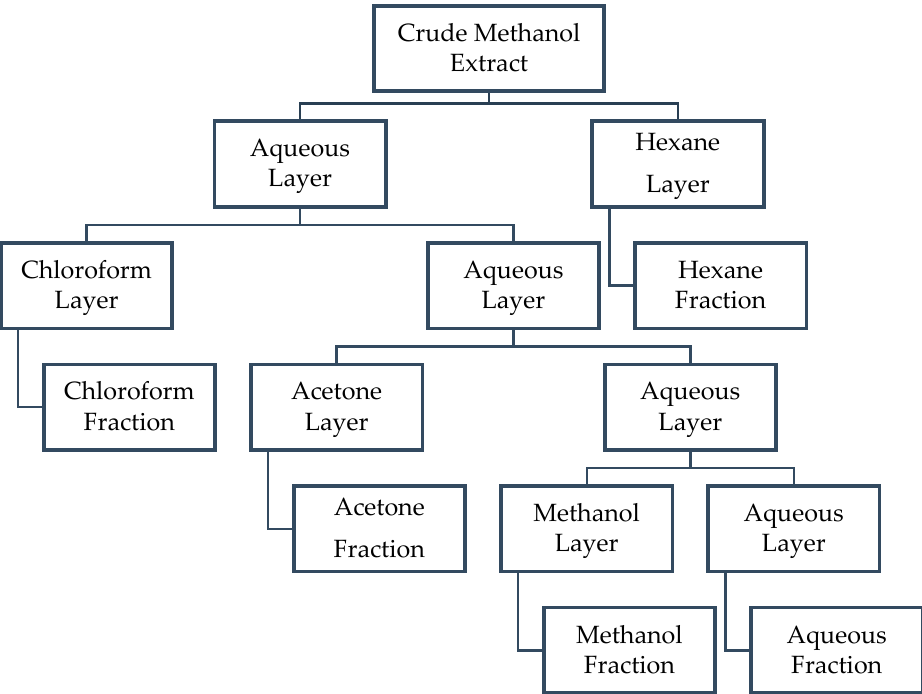
Figure 2. Summary of the scheme used for fractionation to obtain different extracts.